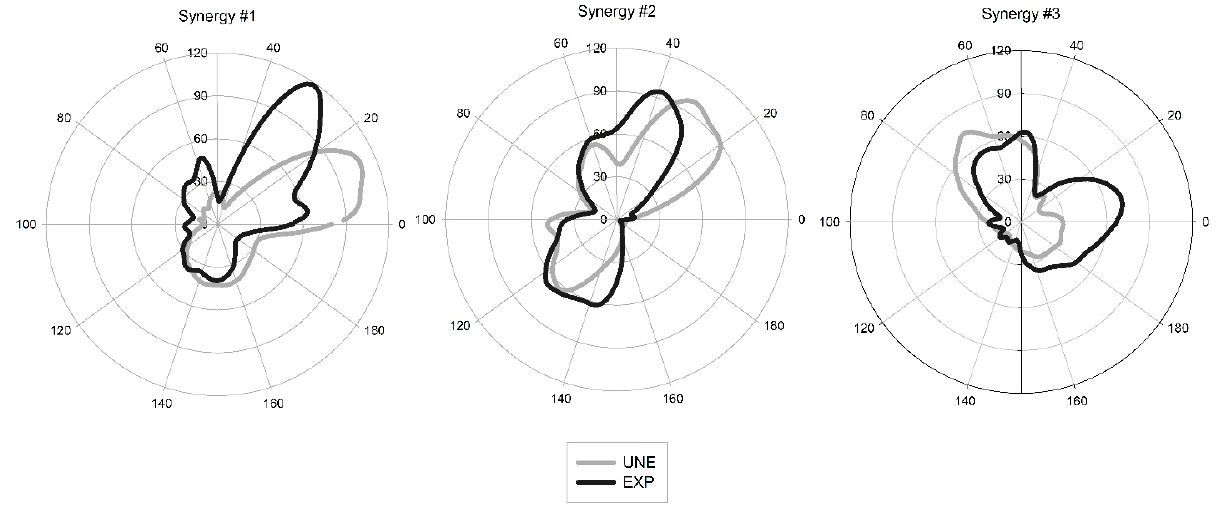
Figure 3. Averaged synergy activation coefficients of weightlifter (EXP) and unexperienced participant (UNE) groups. Left panel refers to Synergy #1, central panel to Synergy #2, and right panel to Synergy #3. The upper hemisphere of the graphs corresponds to the ascendant phase (0–100% of the power clean cycle), while the lower hemisphere corresponds to descendant phase (100–0% of the power clean cycle).